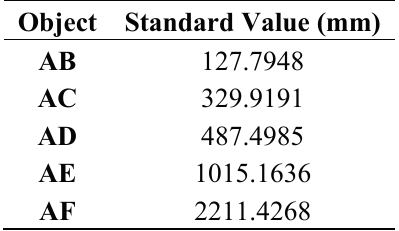
Table 1. All the standard values in the